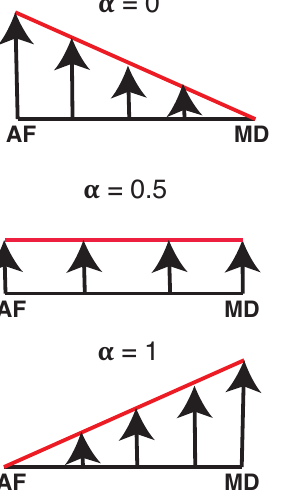
Figure 7. Three extreme cases controlled by the value of α . AF: Alpine Fault; MD: Main Divide.